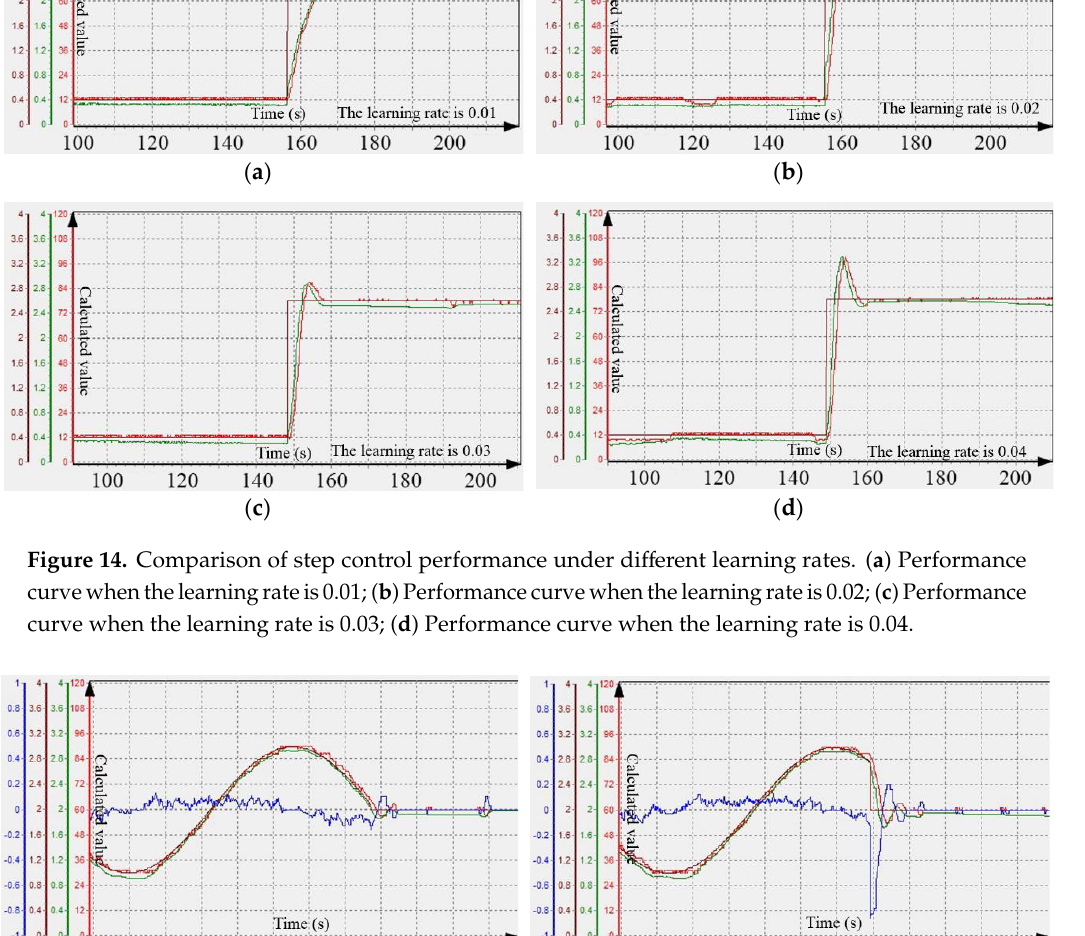
Figure 15. Dynamic characteristics analysis of reference model switching condition. ( a ) Curve converted